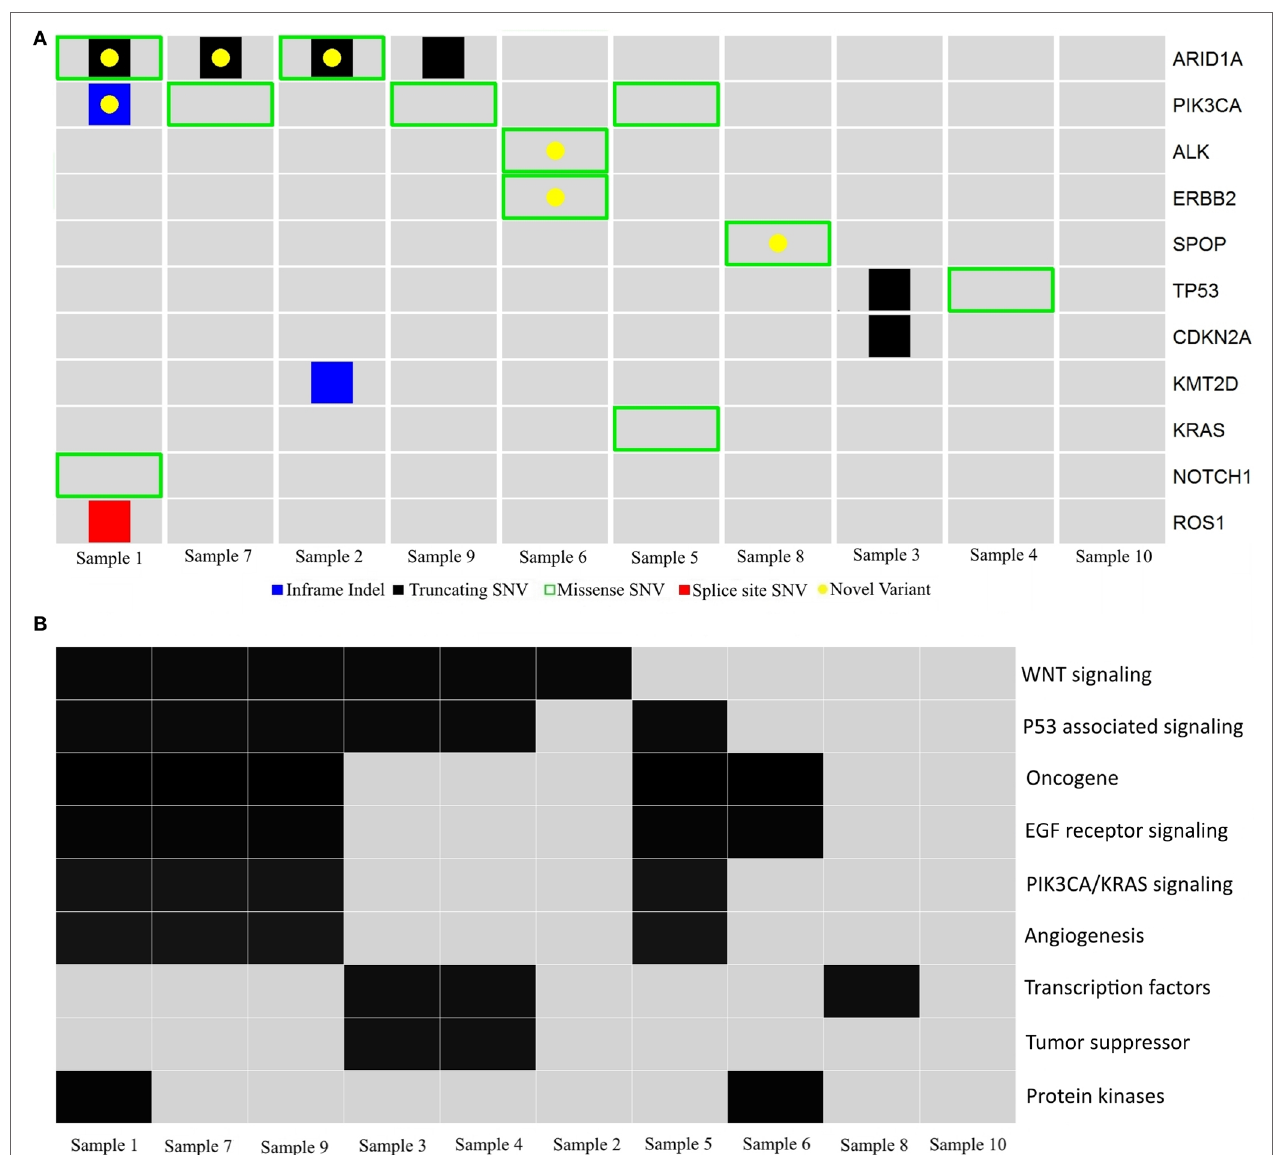
FigUre 3 | schematic diagram of gene variants in ovarian clear cell carcinoma . (a) Illustration of probable somatic variants in genes (rows) across tumors (columns) in cohort 2. Red, splice site SNV; black, truncating SNV; green, missense SNV; blue, inframe indels; yellow, unreported variants. (B) Summary of pathways and gene families (rows) affected by probable somatic variants across tumors (columns) in cohort